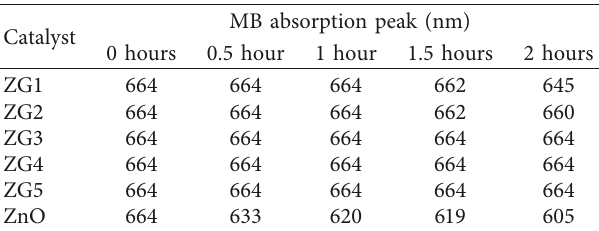
Figure 1: (a) Relative absorbance intensities of ZG1, ZG2, ZG3, ZG4, ZG5, and ZnO as a function of time of irradiation with UV light; (b) kinetic study of MB photodegradation with varying amounts of Zn:GO. Table 1: MB absorbance peak location for every time interval of UV